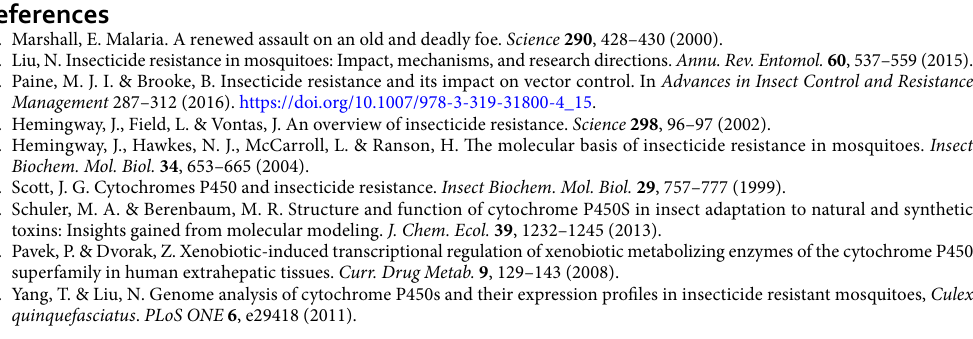
Table 1. Oligo nucleotides for qRT-PCR, dsRNA synthesis. a The transcript ID number from the vectorbase of the Cx. quinquefasciatus genome sequence (http:// cquin quefa sciat us. vecto rbase. org/). b The annotation of the Culex P450 genes from http:// drnel son. utmem. edu/ Cytoc hrome P450. html. c Specific primer pair designed according to each of the P450 gene sequences of the Cx. quinquefasciatus in vectorbase (http:// cquin quefa sciat us. vecto rbase.